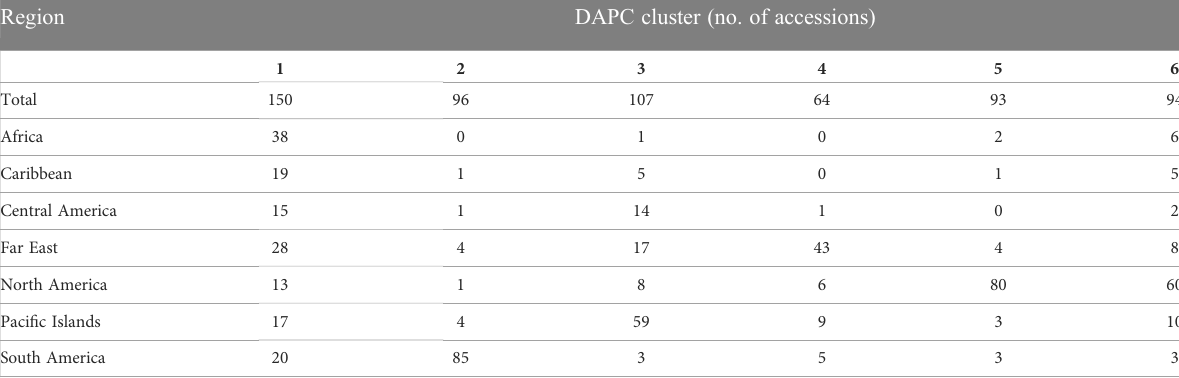
TABLE 3 Discriminant analysis of principal components (DAPC) cluster assignment by region of 604 sweetpotato ( Ipomoea batatas ) accessions.